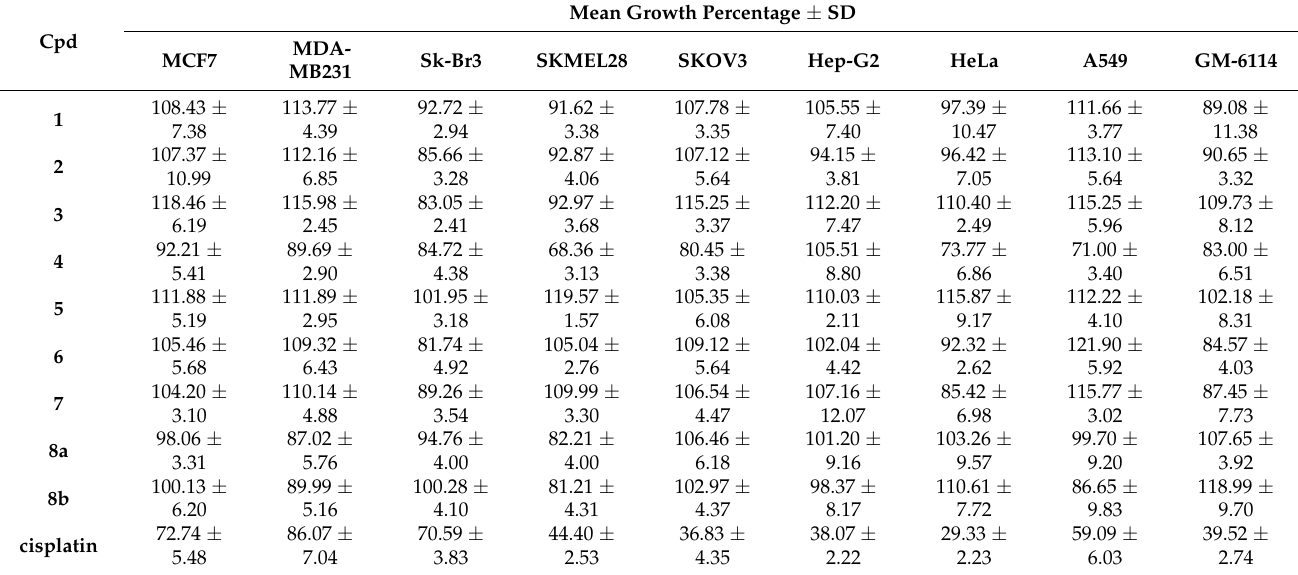
Table 2. Antiproliferative activity of pyrazoles 1 – 8 a